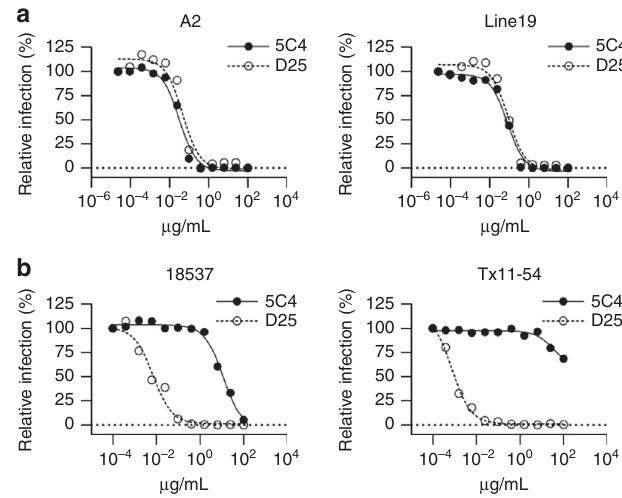
Fig. 1 5C4 is a potent subtype A-speci fi c neutralizing antibody. a Neutralization potency of 5C4 (closed circles) and D25 (open circles) against RSV subtype A strains A2 (left) and Line19 (right). b Neutralization potency of 5C4 and D25 against subtype B strains 18537 (left) and Tx11-54 (right), depicted as in a . The data in panels a and b are representative of two independent experiments performed in